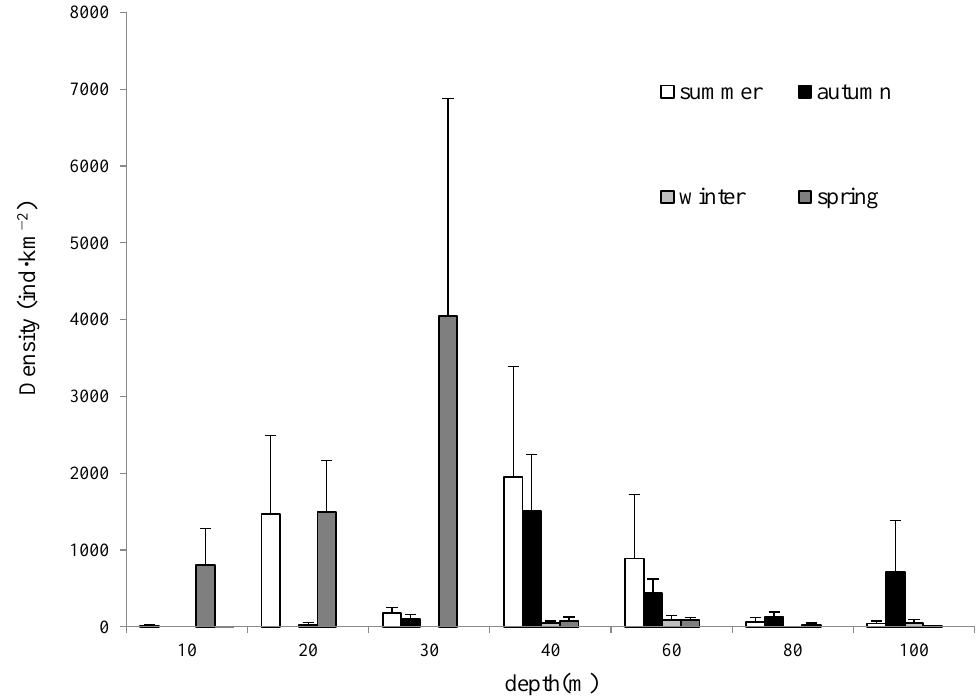
Figure 6. Temporal distribution of biomass ( upper ) and density ( lower ) by depth. Error bars indicate SE.